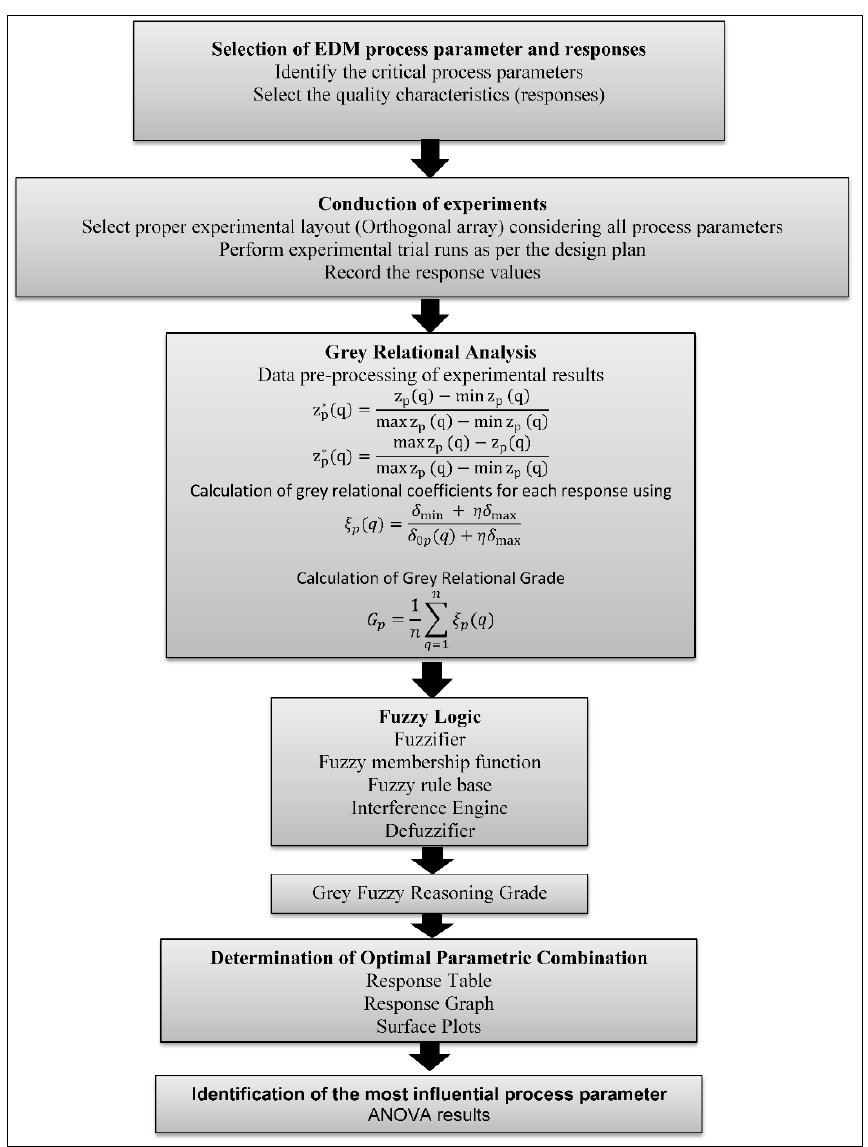
Figure 2. Grey-fuzzy approach for the EDM process.